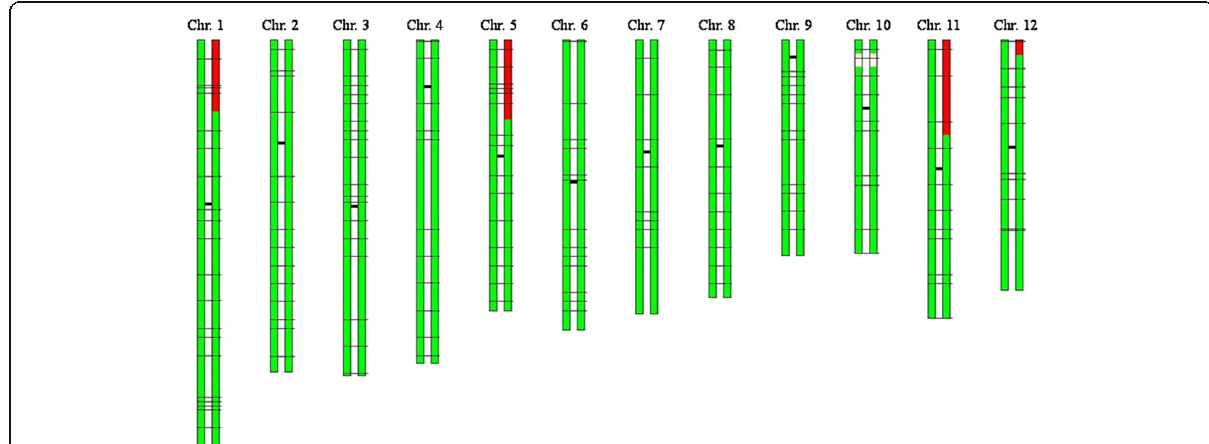
Fig. 3 Graphical genotype (GGT) of BC 3 F 1 -22F01. Green bars represent the chromosome fragments derived from Kongyu 131, red bars represent the chromosome fragments derived from GKBR, and white bars represent unknown fragments; the black horizontal lines indicate the SNP markers (the shorter, darker lines represent the centromeres)